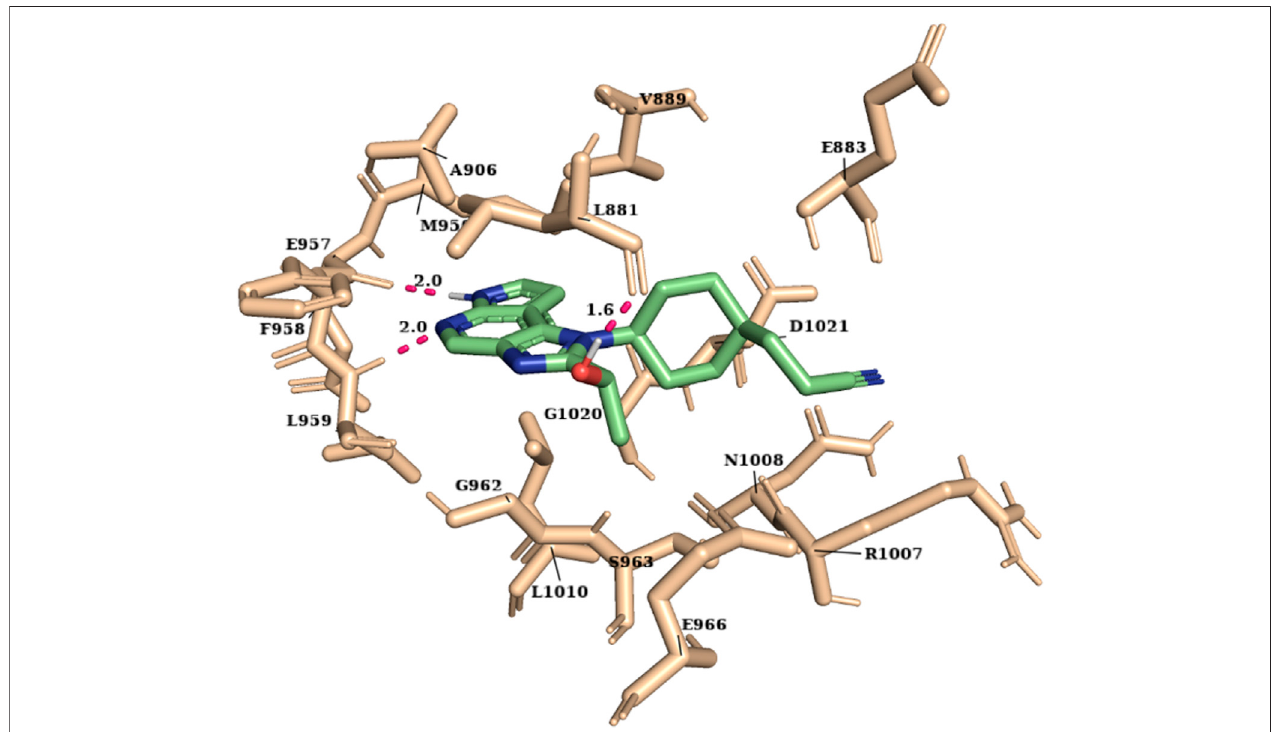
FIGURE 2 | The binding of highly active compound 51 into the ATP-binding site of